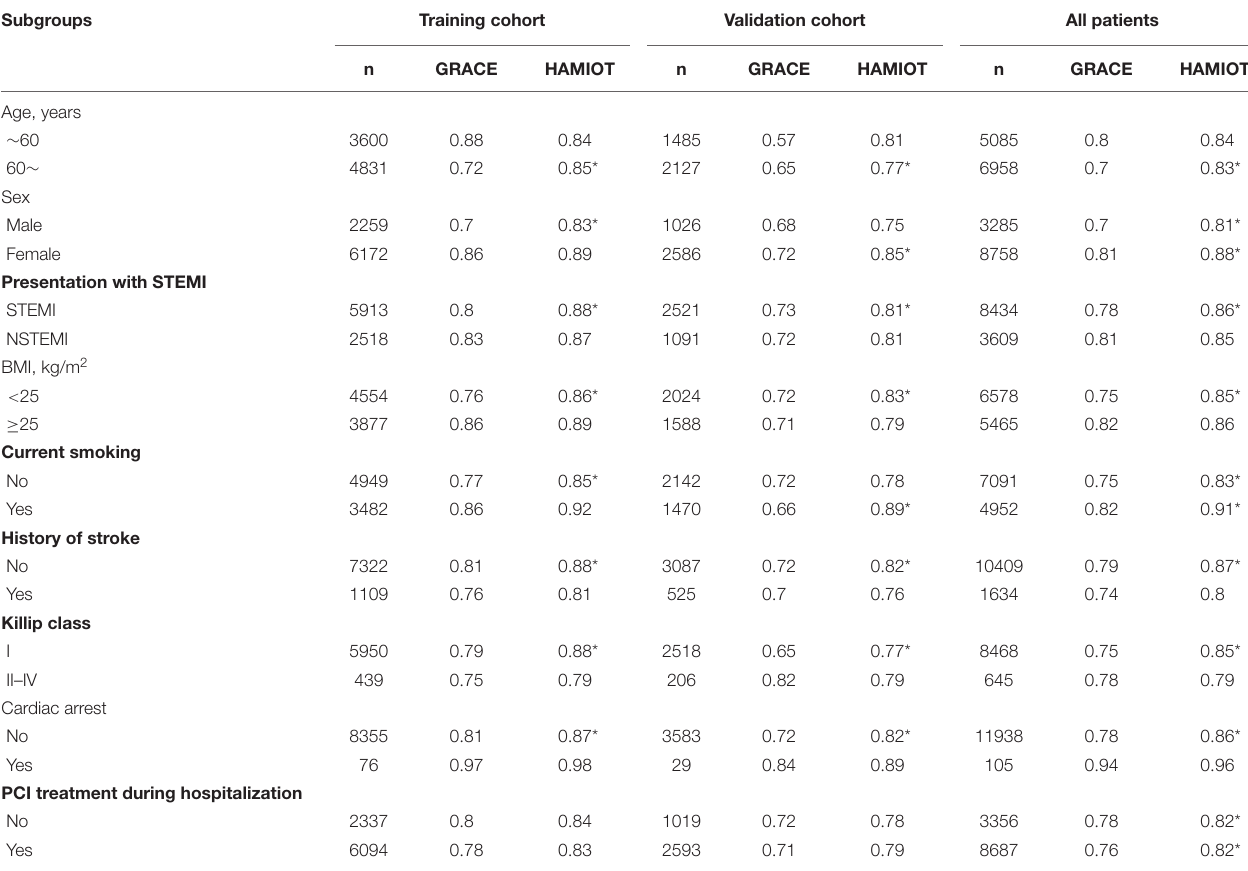
TABLE 4 | The performance of discrimination ability in the subgroups between the HAMIOT risk score and GRACE risk score. Subgroups Training cohort Validation cohort All patients GRACE HAMIOT GRACE HAMIOT GRACE HAMIOT